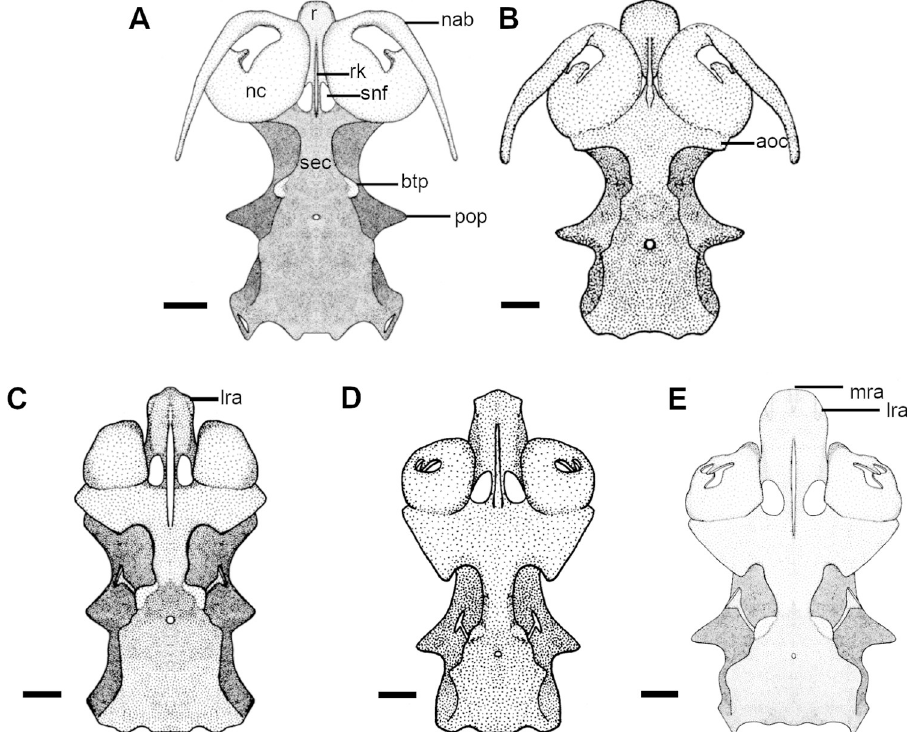
Fig 4. Neurocranium of species of Cirrhigaleus and Squalus in ventral view. A: C . barbifer , HUMZ 95177, juvenile female, 584 mm TL; B: C . australis , CSIRO H7042-04, juvenile female, 605 mm TL; C: S . suckleyi , HUMZ 87643, adult male, 665mm TL; D: S . megalops , AMS I46093-001, adult male, 650 mm TL; E: S . mitsukurii , NSMT P-44381, juvenile male, 770 mm TL. Abbreviations: aoc: antorbital cartilagem; btp: basitrabecular process; nab: nasal barbel; nc: nasal capsule; pop: postorbital process; r: rostrum; rk: rostral keel: sec: subethmoid chamber; snf: subnasal fenestra; lra: lateral rostral appendage; mra: medial rostral appendage. Scale bars: 10mm.